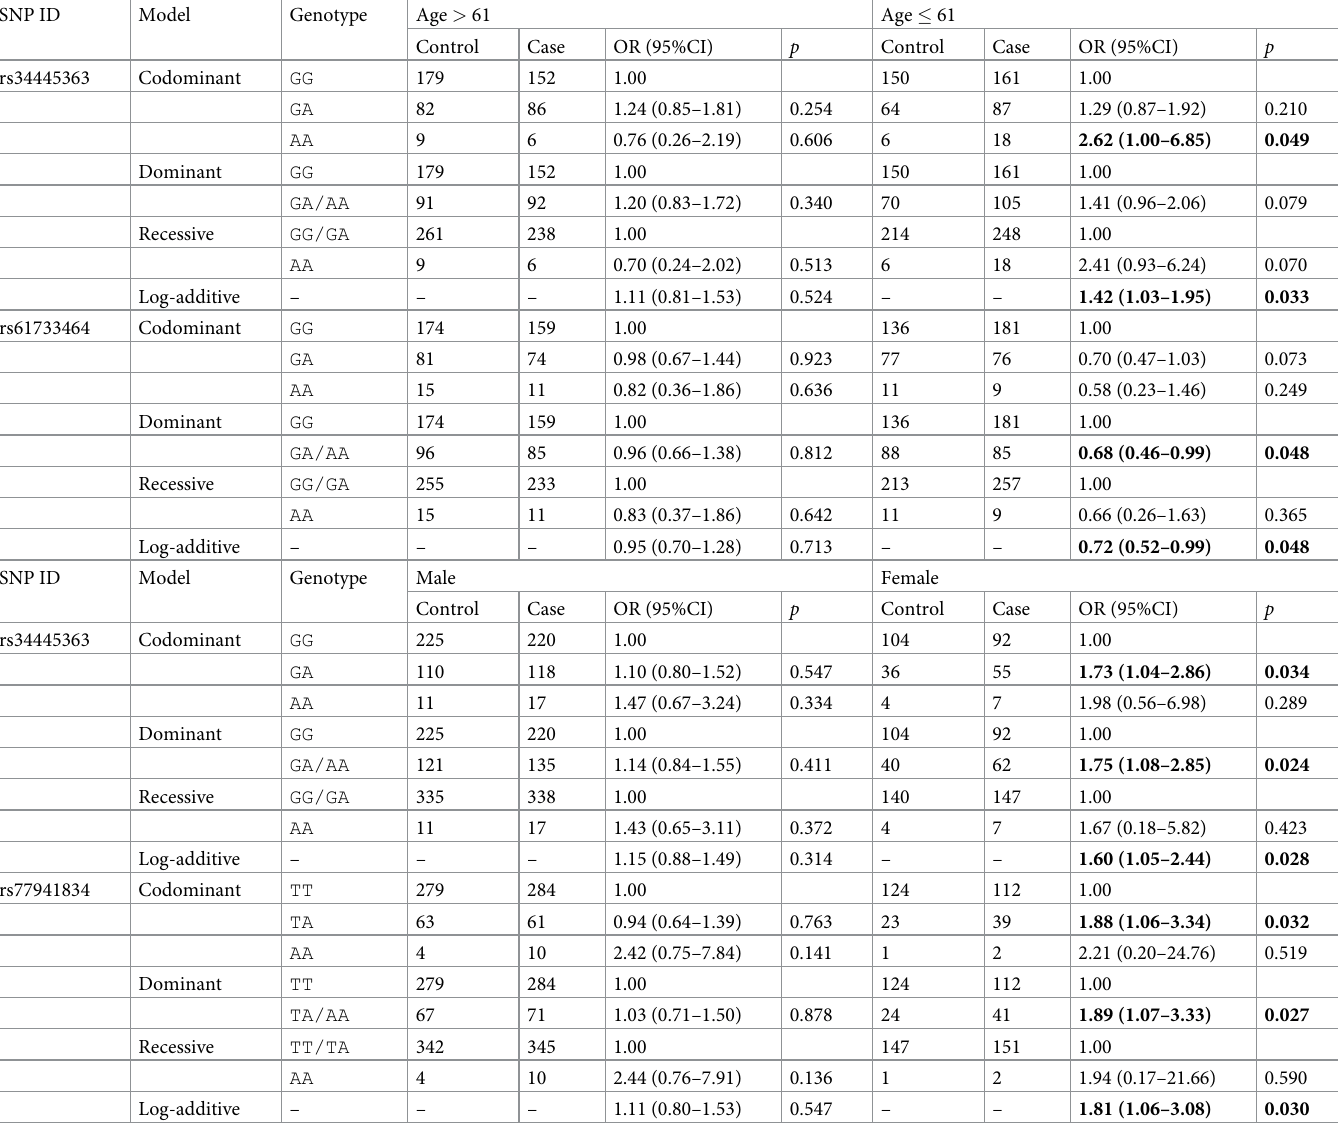
Table 5. Distribution of COL6A4P2 polymorphisms in populations of different ages and genders and its association with risk of lung